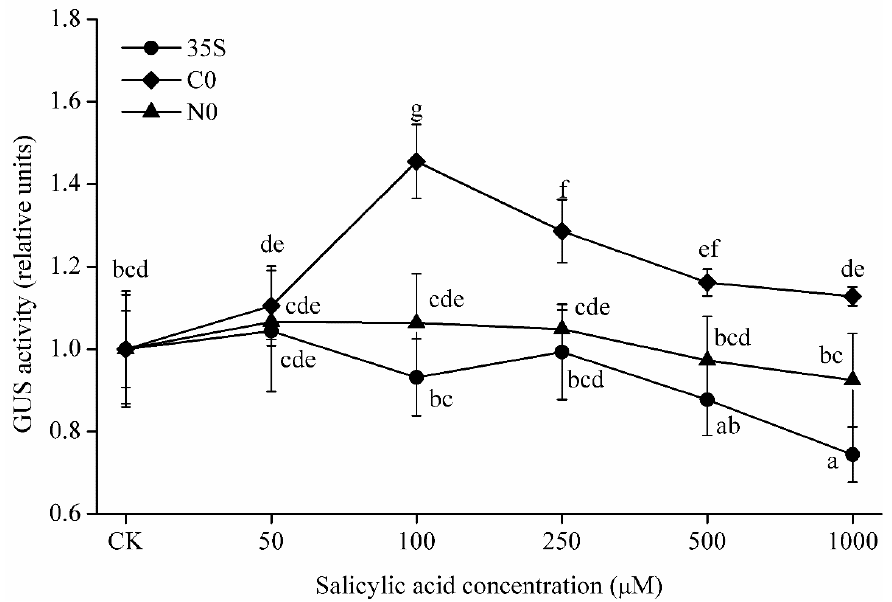
Figure 4. Relative GUS activity in 35S, C0, and N0 lines at a series of exogenous SA concentrations (0, 50, 100, 250, 500, and 1000 μ M). Relative GUS activity was calculated as the activity of the treated transgenic line divided by the activity of its untreated control. Bars represent the mean ± SD, and different letters indicate significant differences ( p < 0.05) based on Duncan’s test ( n = 3).